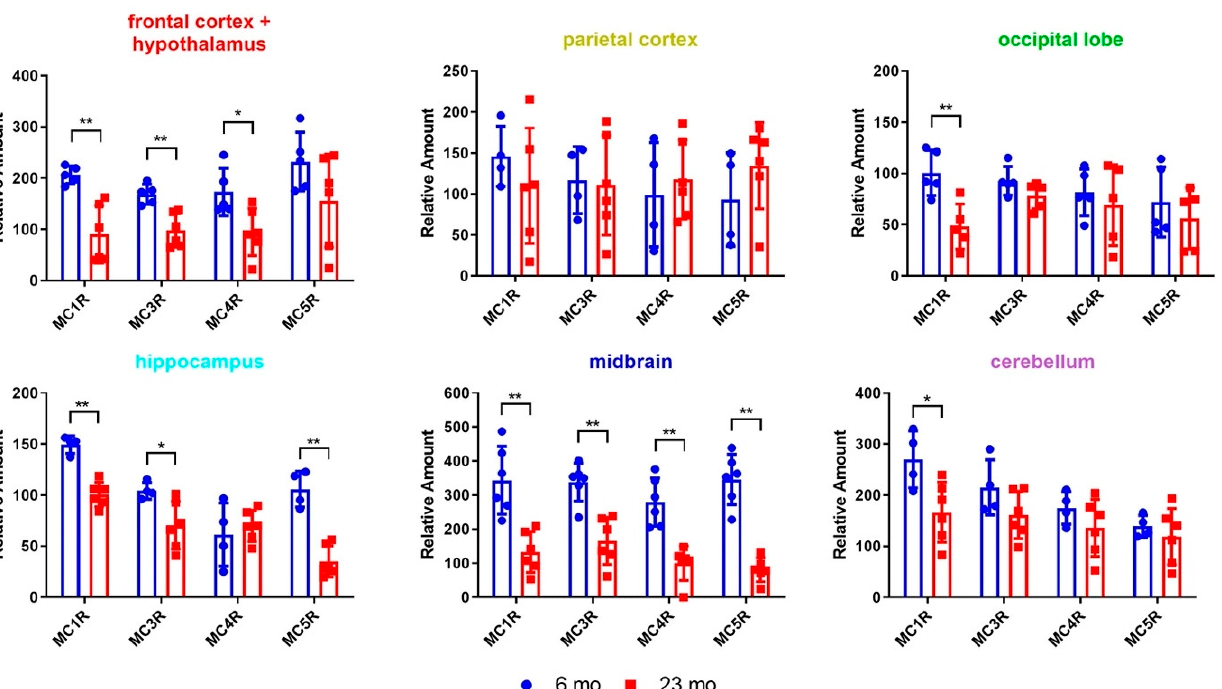
Figure 3. Subtype specific binding of 125 I-NDP-MSH to different brain regions of 6 mo ( n = 6) and 23 mo ( n = 6) rats. Statistical significance was calculated by a Student’s t -test. * indicates p < 0.05. ** indicates p < 0.01.